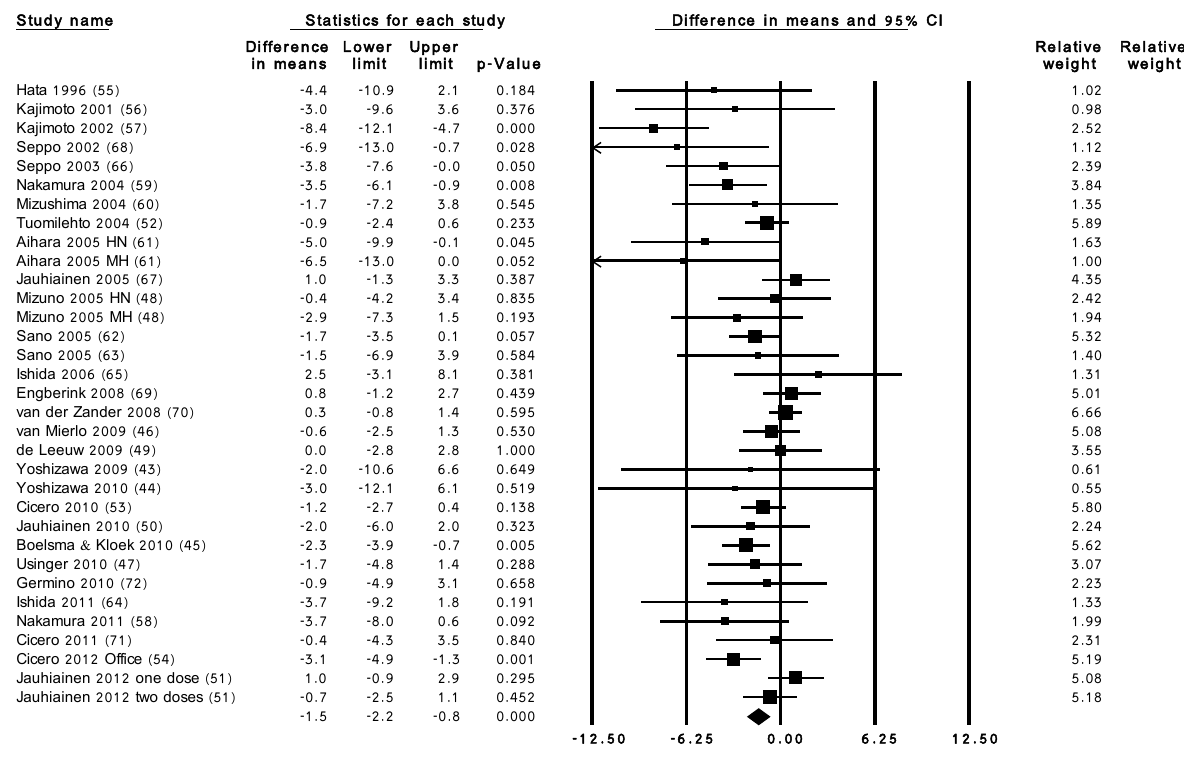
Figure 2. Overall change in DBP (mmHg) after LTP supplementation. HN, high-normotensives; MH, mild-hypertensives; 0.000 refers to p<0.001. Weighted mean